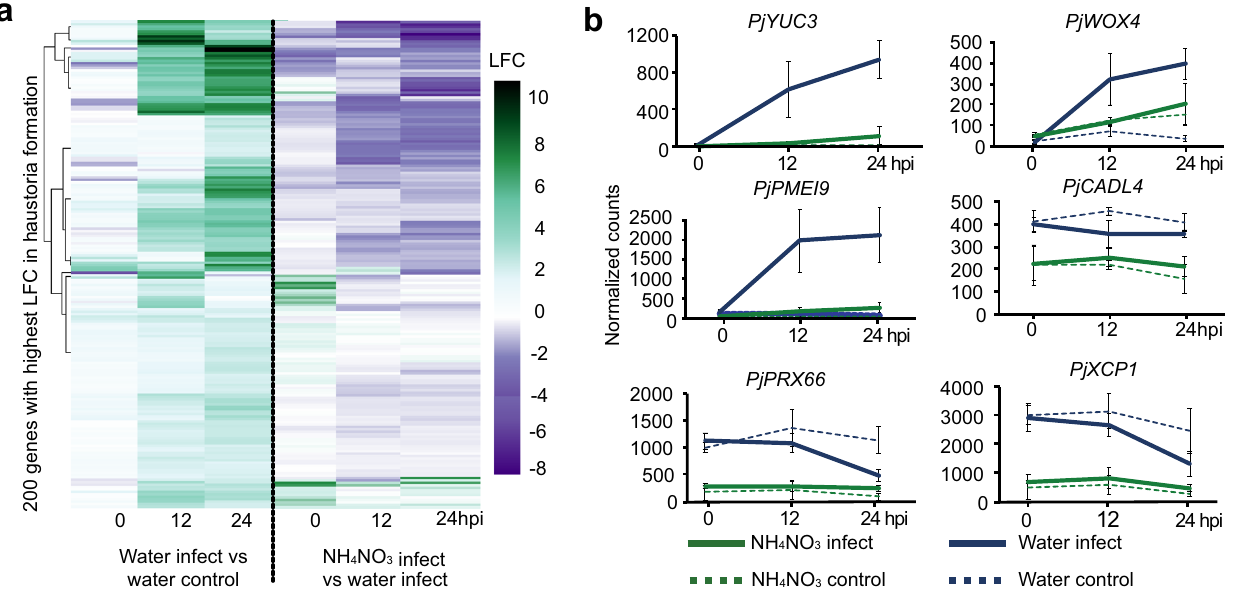
Fig. 3 NH 4 NO 3 treatment modi fi es P. japonicum gene expression . a Heatmap of 300 P. japonicum genes with the highest log2 expression fold change during haustoria formation over three time points in the water infect vs water control and NH 4 NO 3 infect vs water infect. b Normalized P. japonicum counts of PjYUC3, PjWOX4, PjPMEI9, PjXCP1, PjCADL4, PjPRX66 over three time points shown for control and infect in the NH 4 NO 3 and water treatments (mean ± SD, n = 3